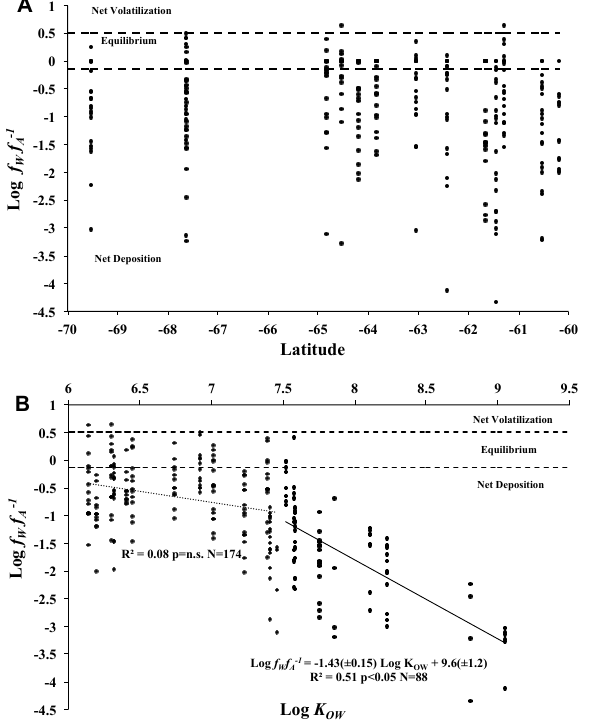
Fig. 4. Air-water dis-equilibrium of PCBs. Estimated congener spe- cific air/water fugacity ratios (log f W /f A ) calculated for the ES- SASI and ATOS II cruises versus latitude (A) , and versus the tem- perature corrected octanol water partition coefficient, Log K OW (B) .